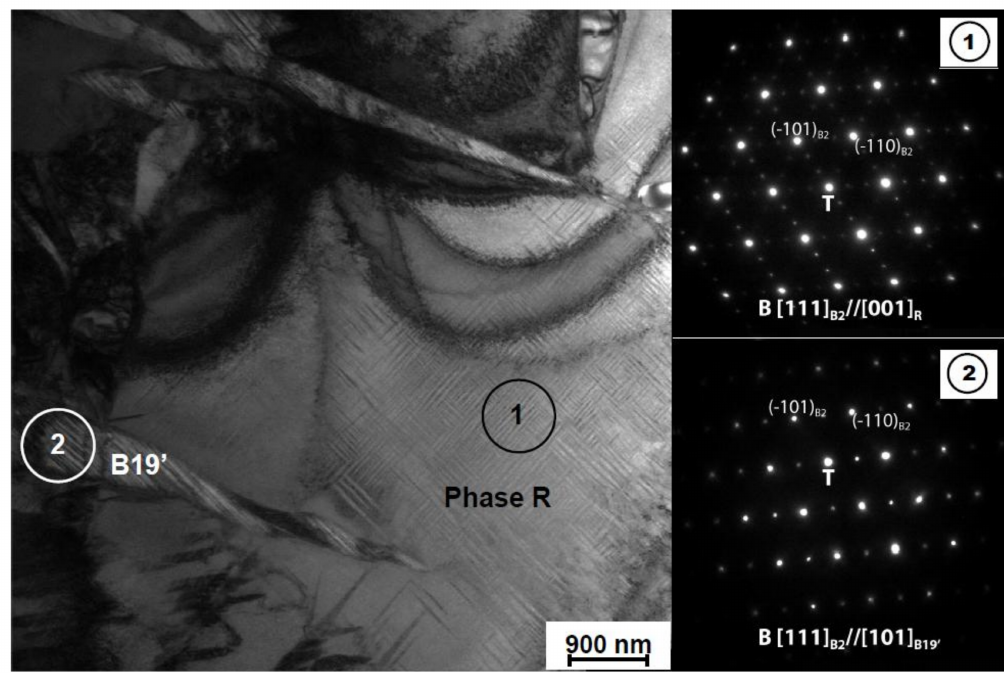
Figure 6. Preliminary transmission electron microscopy (TEM) study performed using a Philips CM200 microscope (Amsterdam, The Netherlands) on an electron transparent lamella obtained by electropolishing. On the left, a bright field image acquired at − 180 ◦ C from a quenched Ni 50.3 Ti 49.7 electron transparent lamella showing some self-accommodating B19 (cid:48) groups (circle 2) in a matrix completely transformed from austenite to R phase (circle 1). On the right, the microdiffraction patterns corresponding to the R phase ( 1 ) and to the B19 (cid:48) martensite ( 2